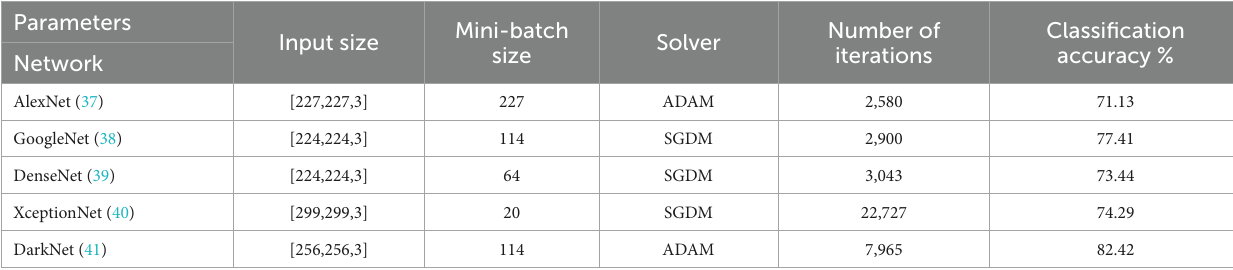
TABLE 3 Trained network parameters and their classification accuracy.